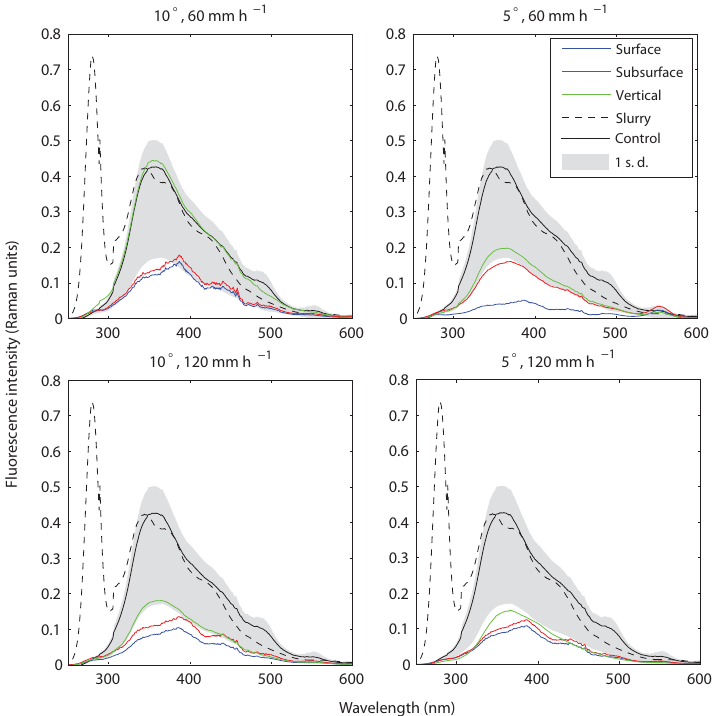
Figure 7. Plots showing the mean fluorescence spectra from the surface runoff, subsurface throughflow and vertical percolated pathways for each slurry-treated experiment along with the average spectra from all pathways of the control experiments and the spectra from the applied slurry. The shaded area represents 1 standard deviation around the mean of the control soil spectra.